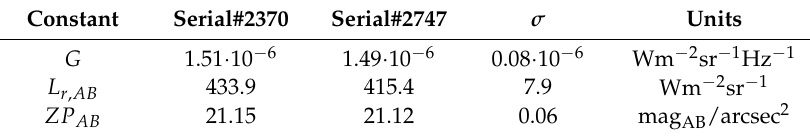
Figure 2. Normalized spectral sensitivity of the of the SQM USB enabled data-logging light meters (SQM-LU-DL) ( a ) #2370, and ( b ) #2747. Table 2. Calibration constants of the SQM-LU-DL night sky brightness meters.